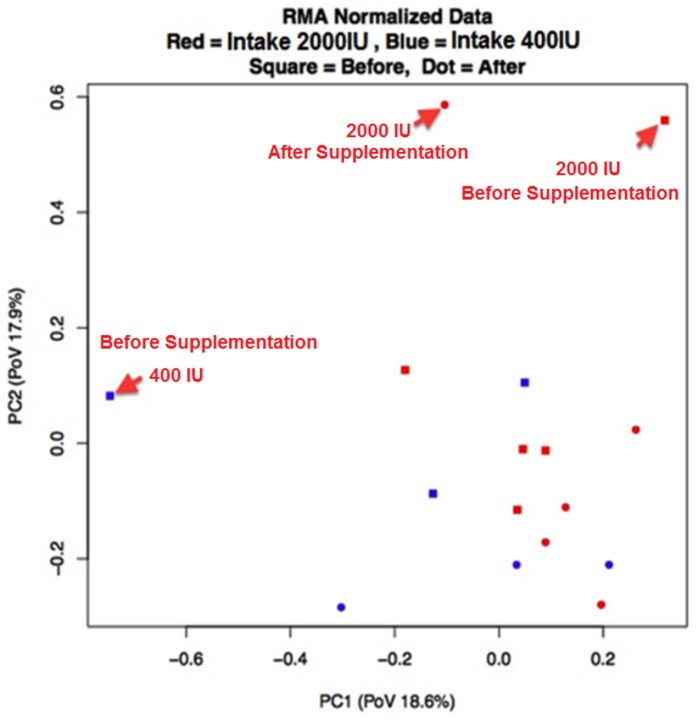
Principal Component Analysis across 16 microarray samples.There is no grouping of samples along the first or second principal components (representing 18.6% and 17.9% of the variance in gene expression, respectively) based on the expression of these genes. Sample types of each group before or after vitamin D3 supplementation are color-coded for the dose of vitamin D3 supplementation. Red =  2000 IUs and blue =  400 IUs (PoV  =  Possibility of Variance.)